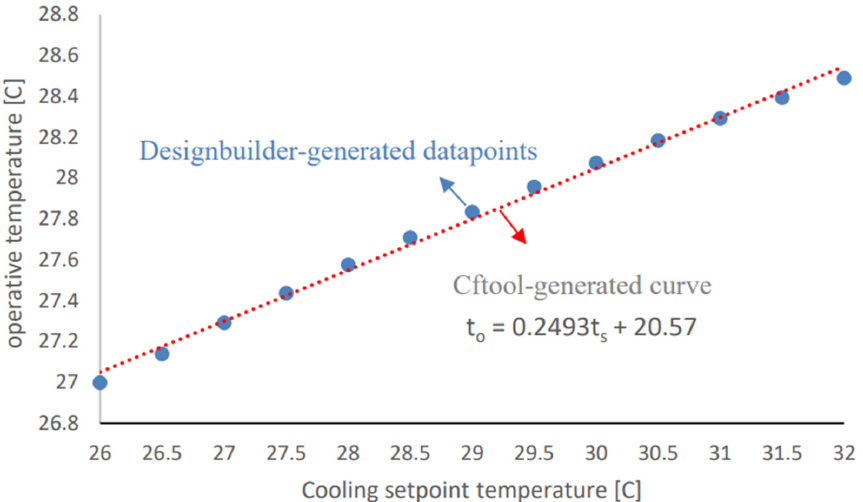
Figure 3. The average annual operative temperature with respect to the cooling setpoint temperature.